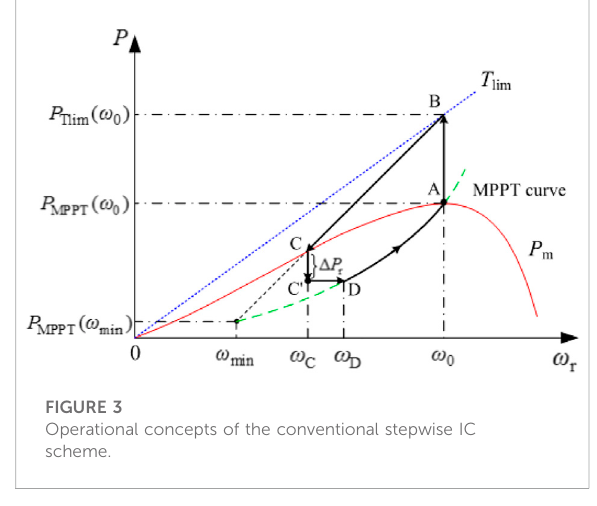
SFR of the single machine model.